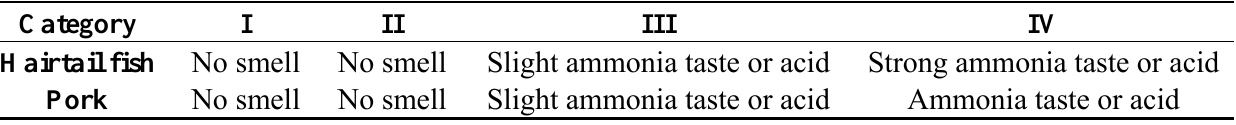
Table 1. Aromas of each classification for hairtail fish and